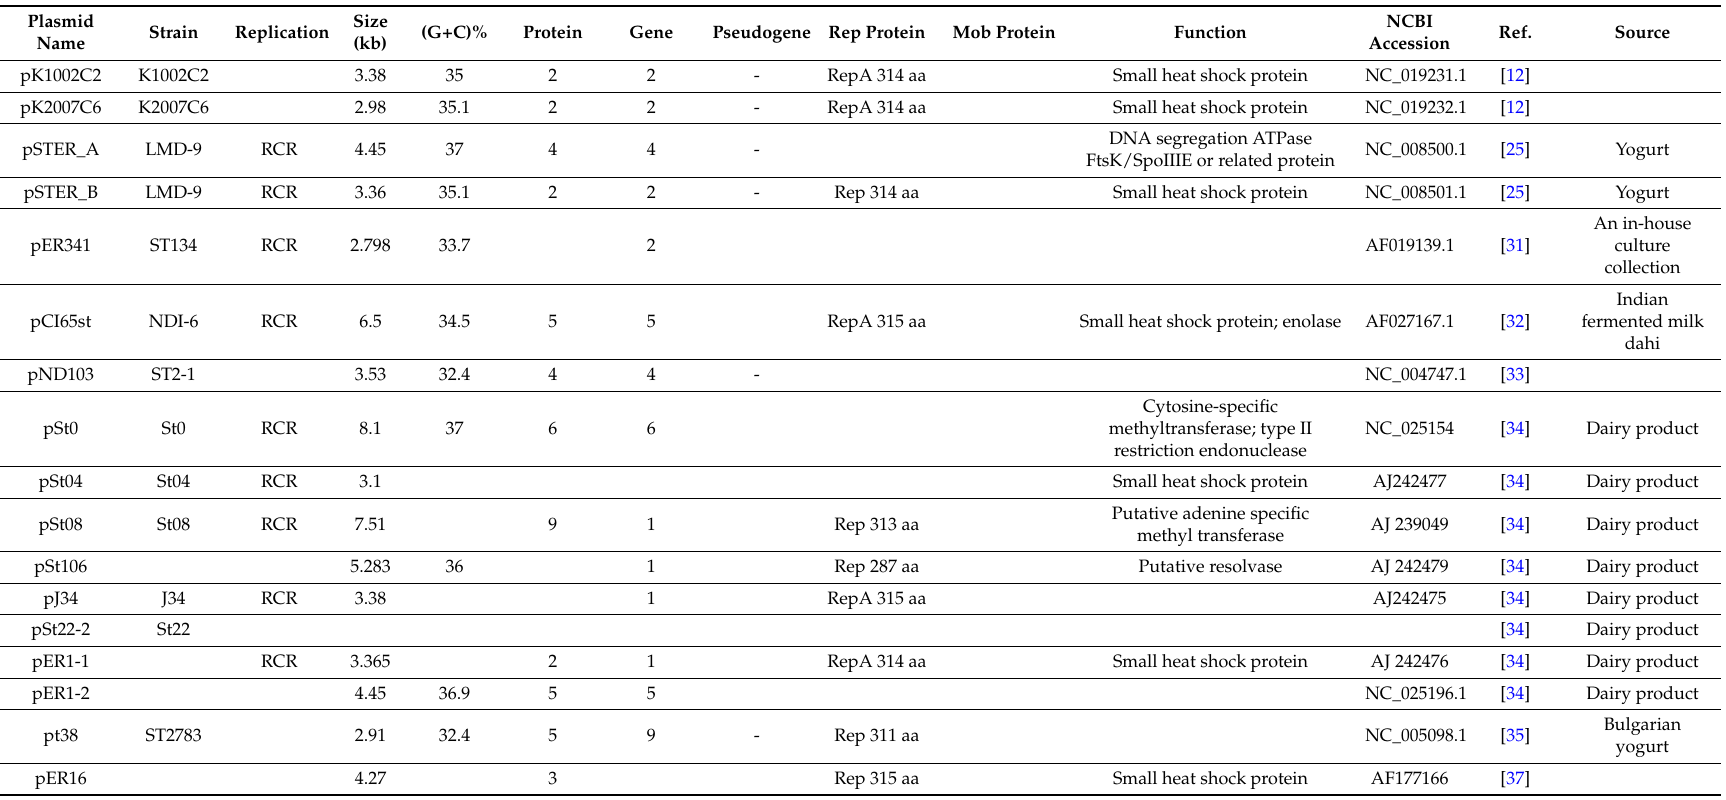
Table A1. The plasmids of Streptococcus thermophilus